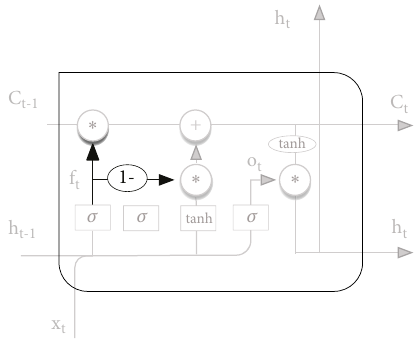
Figure 5: Variant structure 2 of LSTM.